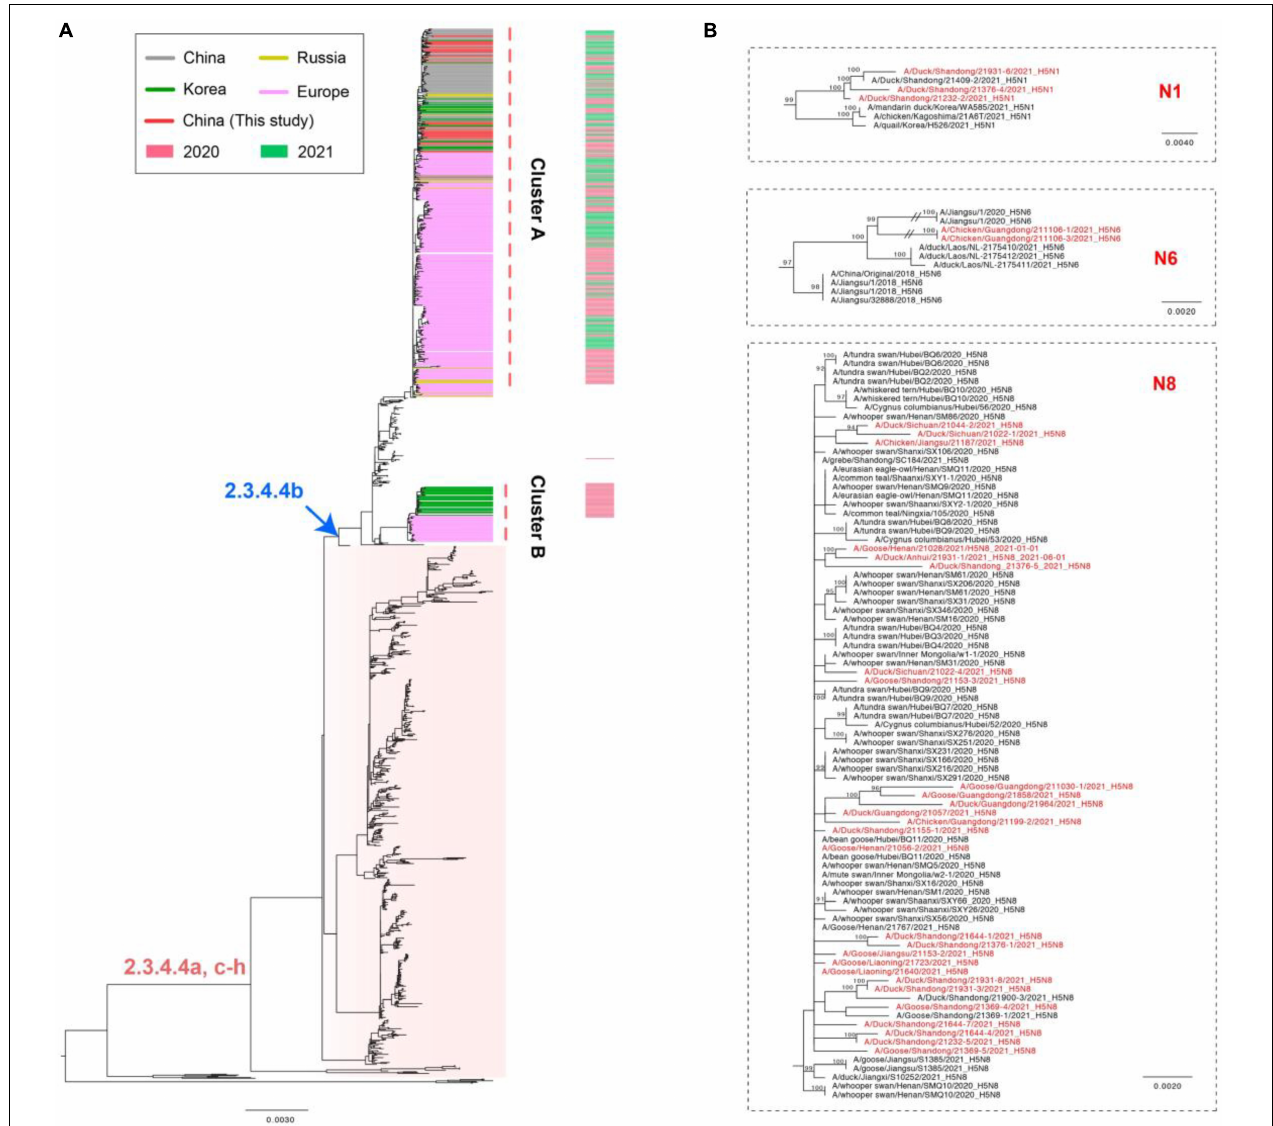
FIGURE 2 | Maximum likelihood (ML) tree of HA (A) and NA (B) gene sequences of H5 subtype viruses. All of the H5Nx viruses in China, including our 30 H5N8 viruses, 3 H5N1 viruses, 2 H5N6 viruses were used to perform the phylogenic analysis. All branch lengths are scaled according to the numbers of substitutions per site (subs/site). ML phylogenies for the codon alignment of the full gene segments were estimated using the best-fit nucleotide substitution model in the IQ-TREE. Node support was determined by non-parametric bootstrapping with 1,000 replicates. The phylogenetic tree was visualized in the FigTree (version 1.4.3) program.